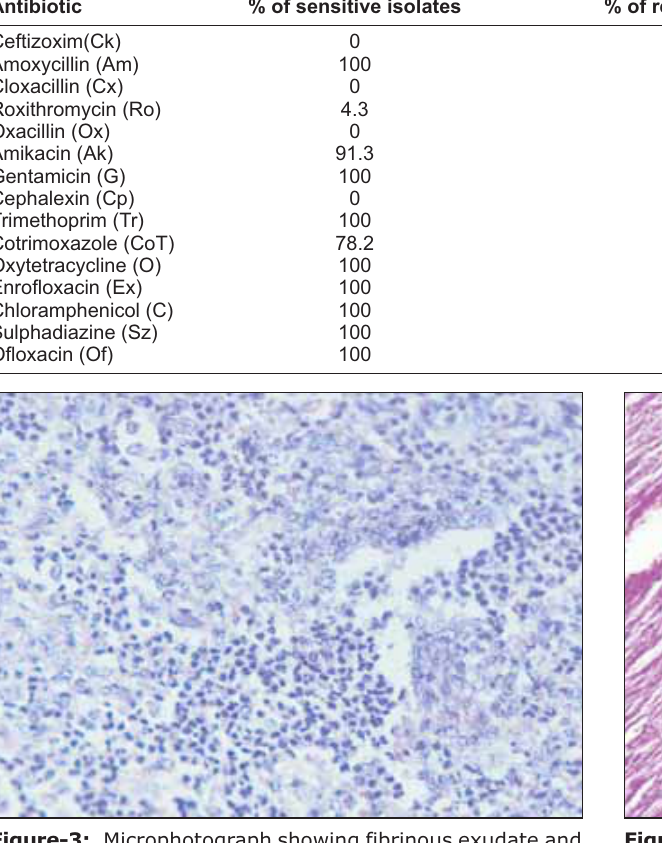
Table-1: Showing the antibiotic sensitivity pattern of P.multocida Antibiotic